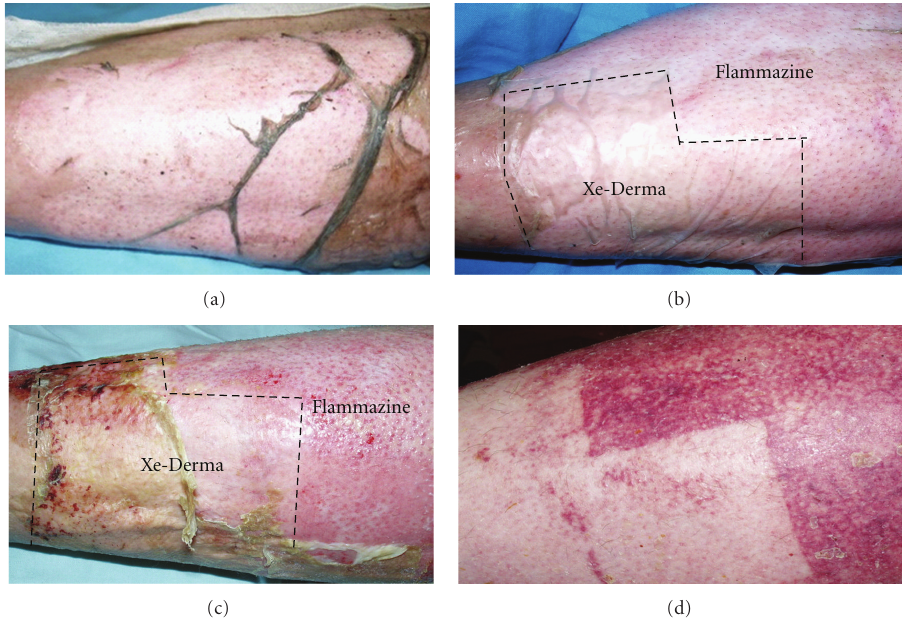
Figure 2: The e ff ect of XD compared to antibacterial cream Flammazine in a patient burned by acetone steam (deep dermal burn). An example of XD healing e ff ect. (a) Day 1: the burn wound on the leg at the initiation of treatment. (b) XD was applied to the distal part of the leg, and the proximal part was covered with silver sulphadiazine (Flammazine). (c) Day 9: the area under XD healed, while the area under Flammazine did not heal until day 18. The XD dressing was not changed during the treatment, while the Flammazine dressing was changed every second day. (d) Day 20: detail of the healed area. The esthetic result and the speed of healing under XD are